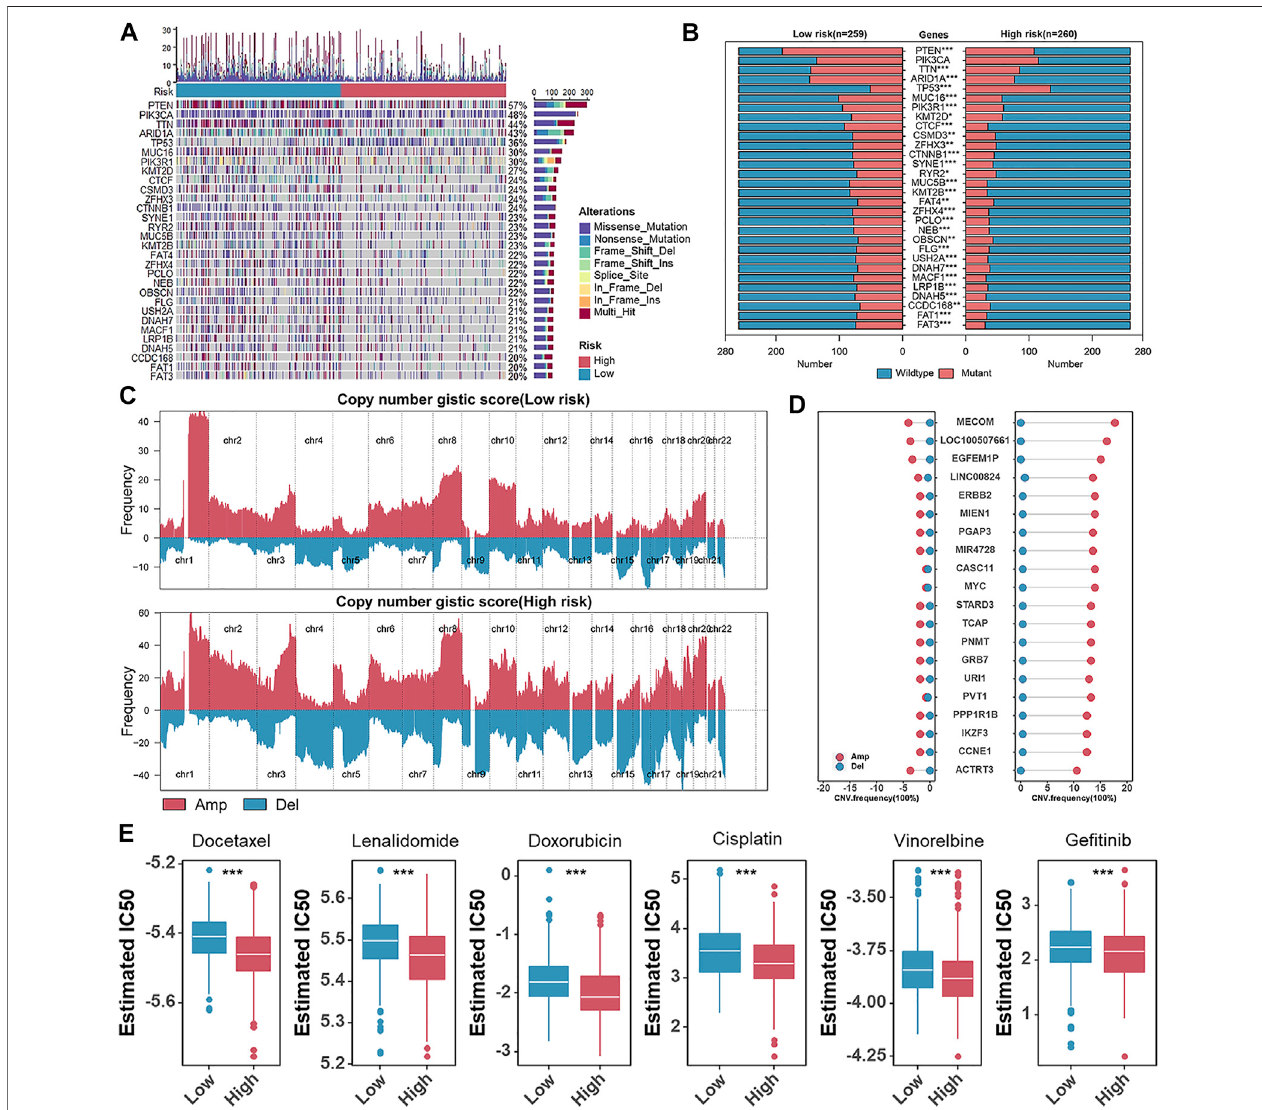
FIGURE 8 | A global vision of genomic alterations and chemotherapeutic response prediction in different risk groups. (A) Oncoplots of the somatic mutation in TCGA-UCEC. (B) The box plots of top 30 somatic mutations genes in the low- and high-risk groups. (C) . Ampli fi cations (Amp) and deletions (Del) of copy number in the low- and high-risk groups. (D) The CNV frequency of the frequently ampli fi ed (Amp) or deleted (Del) genes in TCGA-UCEC. (E) The box plots of the estimated IC 50 of docetaxel, lenalidomide, doxorubicin, cisplatin, vinorelbine, and ge fi tinib.